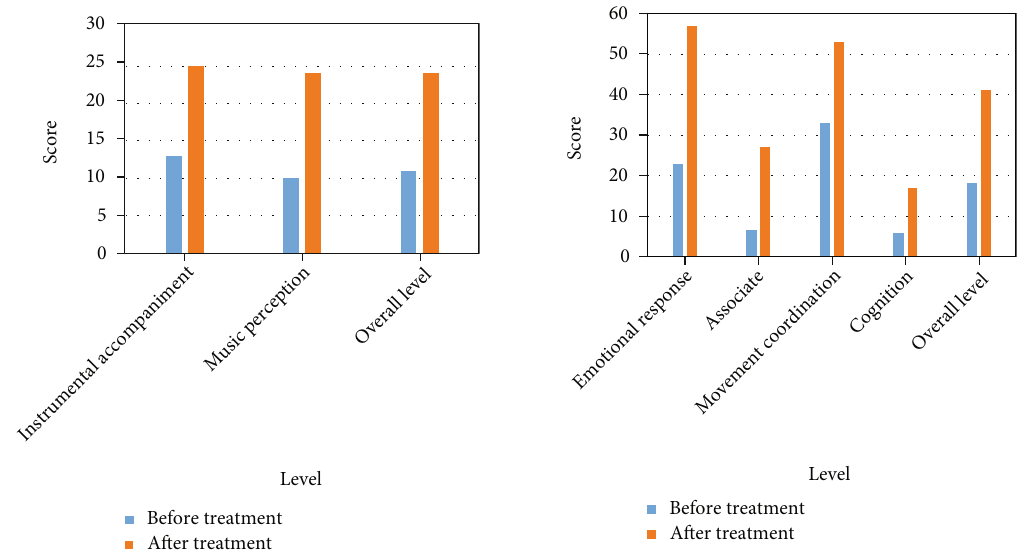
Figure 9: Music expressive ability of Xiao M before and after music therapy, emotional and behavioral expressive